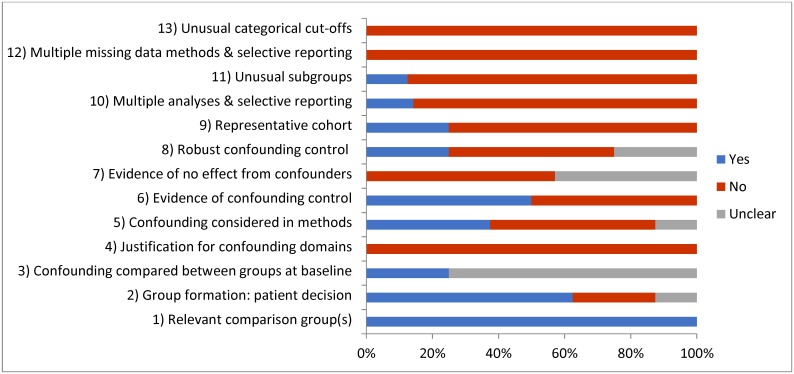
Quality appraisal.